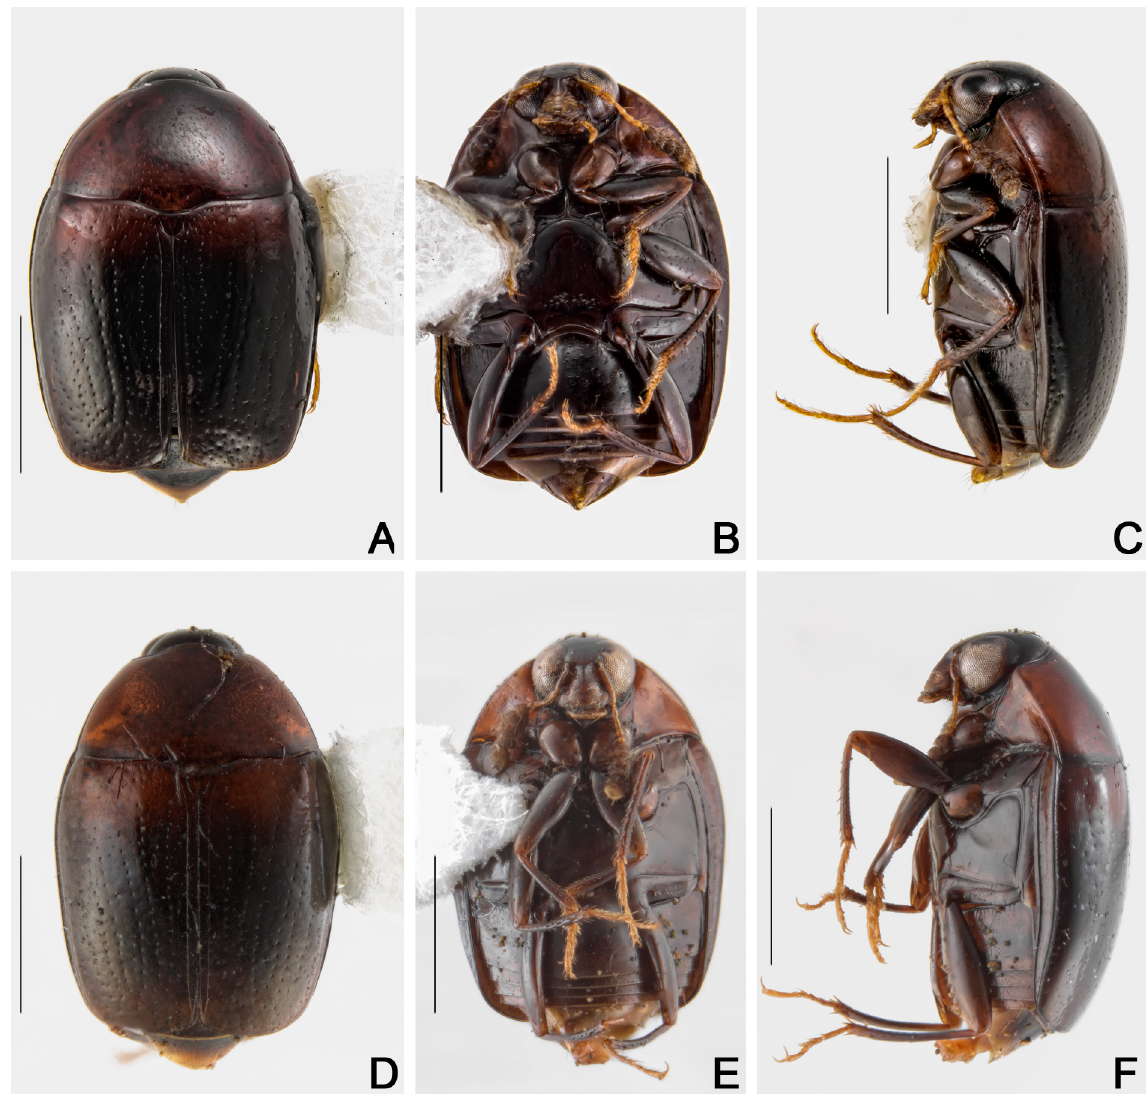
Fig. 22. Cyparium loebli sp. nov. A–C . Holotype, ♂ (CELC). A . Dorsal view. B . Ventral view. C . Lateral view. D–F . Paratype, ♂ (CELC). D . Dorsal view. E . Ventral view. F . Lateral view. Specimens collected at Mata do Paraíso, Viçosa (MG, Brazil). Scale bars = 1.0